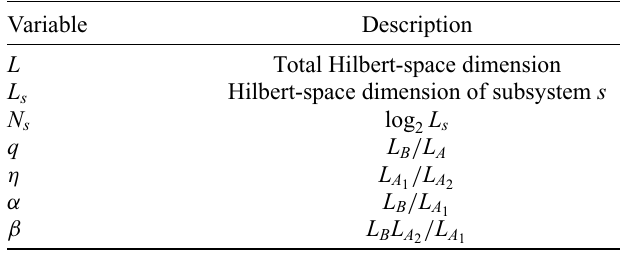
TABLE I. Summary of notations in the paper.